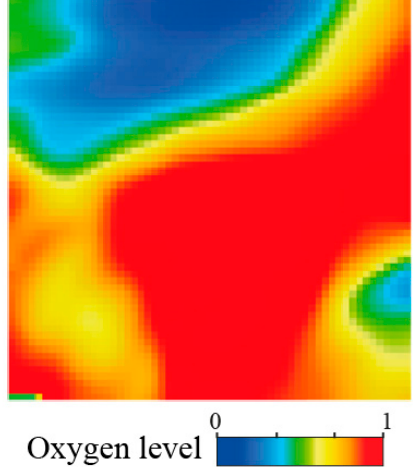
Figure 12. Oxygen level at sea-floor map for a meta-model with a high oxygen mixing rate (0.98) and a fairly high PP0 (225 gC · m − 2 · year − 1 ). We can expect anoxic environments in the blue areas that correspond to the deepest parts of the basin. With this setting, the anoxia is only driven by the high amount of primary productivity.